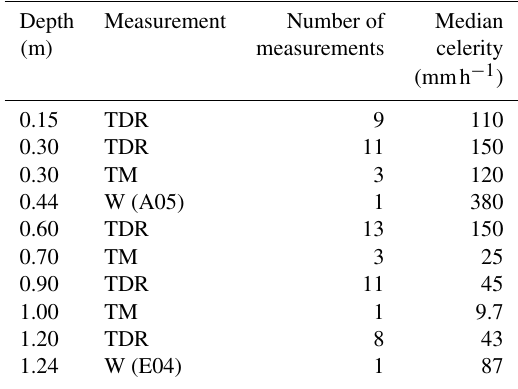
Table 1. Median wetting front celerities estimated from different types of measurements (W indicates a well, TDR indicates time do- main reflectometry and TM indicates a